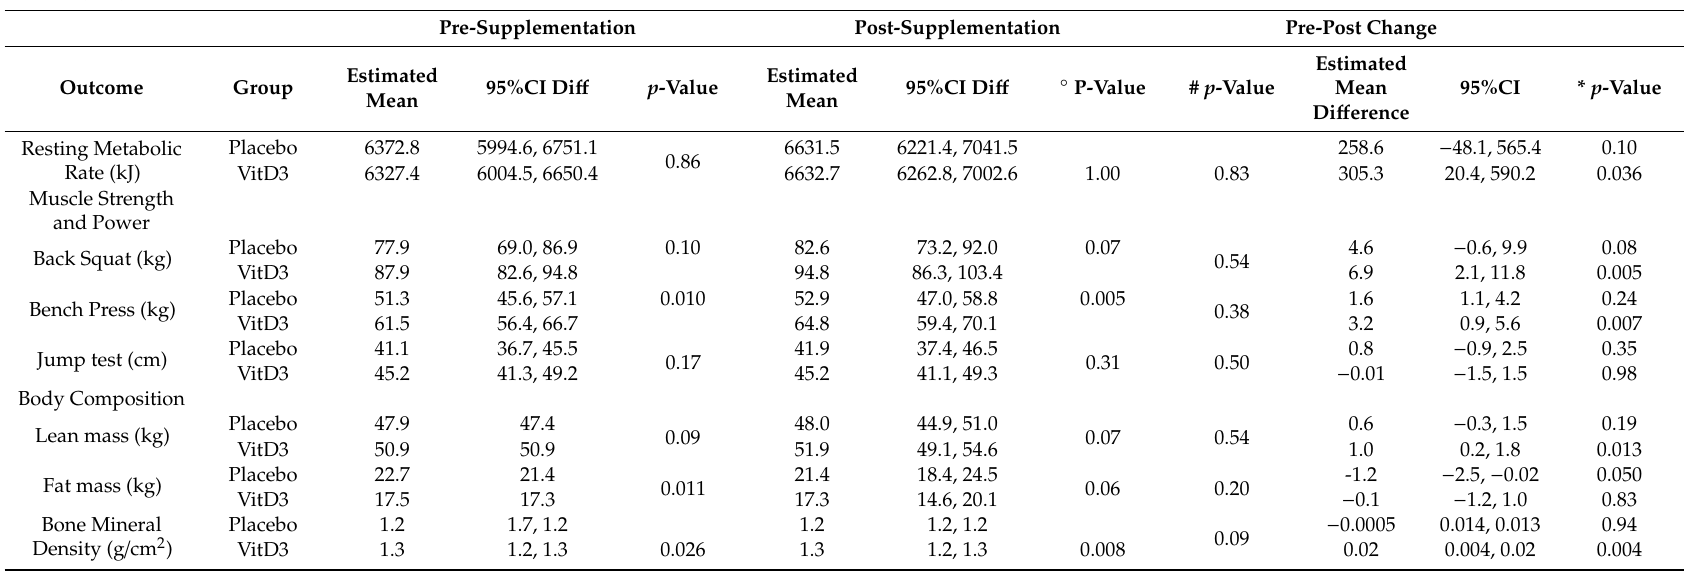
Table 2. Estimated within-group means and mean di ff erences of outcomes (pre- and post-supplementation) considering serum total 25(OH)D as the main predictor. Predictor = Model Adjusted For: Gender, Sunlight Exposure, Training Load, Protein, Carbohydrate, Fat and Energy